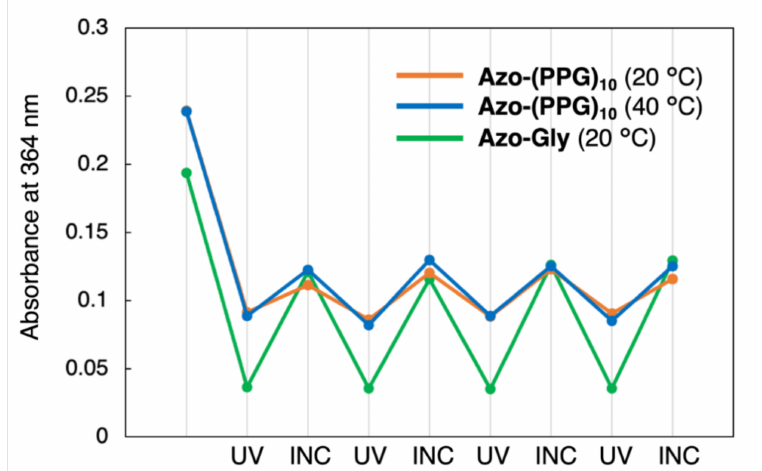
Figure 5. Reversibility of the conformation of the azobenzene moiety at 20 and 40 ◦ C upon UV irradiation (365 nm, 1 min), and incubation at room temperature in the dark (5